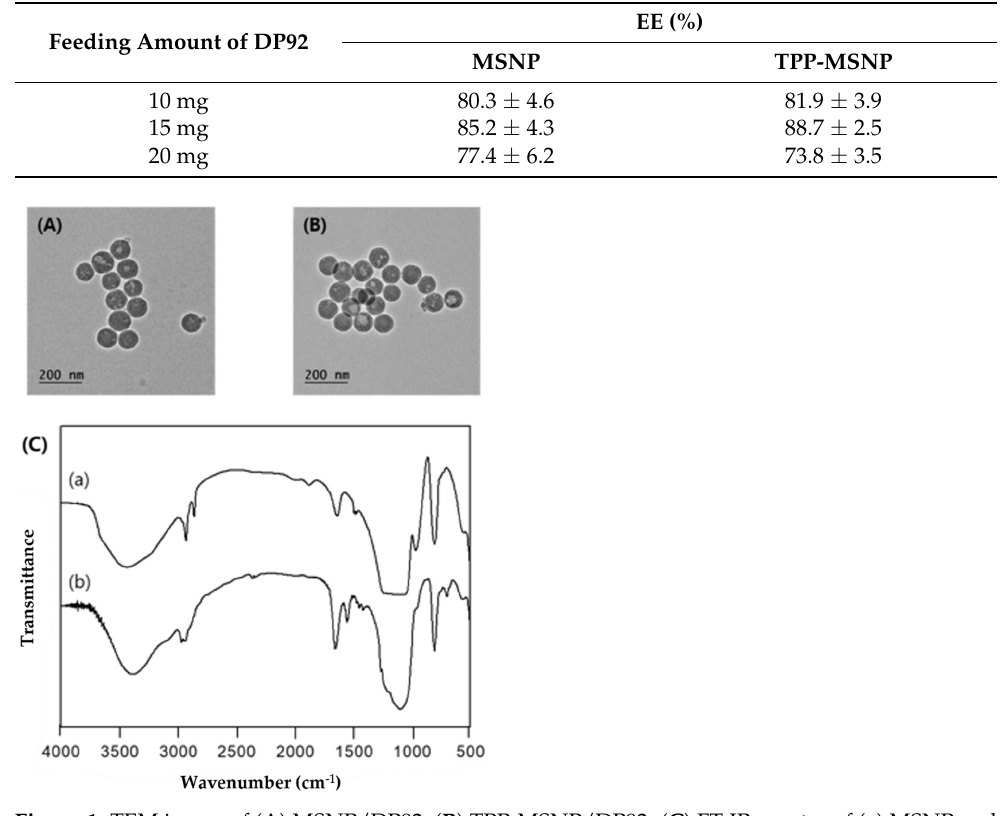
Figure 1. TEM image of ( A ) MSNP/DP92, ( B ) TPP-MSNP/DP92. ( C ) FT-IR spectra of (a) MSNP and (b) of MSNP-APTES-TPP.